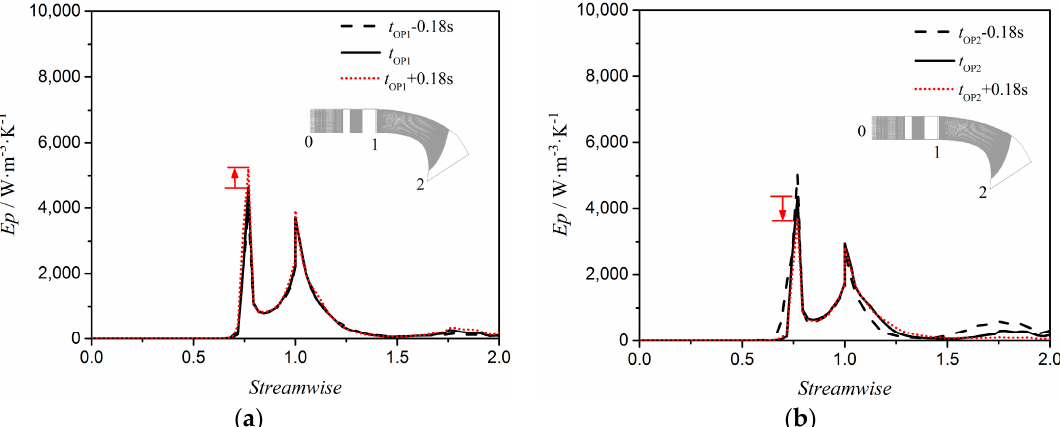
Figure 13. Changes of the distribution of entropy production rate Ep along the streamwise direction of flow passages at no-load points OP1 and OP2 for 6° GVO; ( a ) in the forward direction; ( b ) in the backward direction.